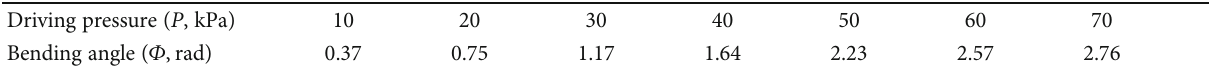
Figure 6: Pressurize expansion and bending of pneumatic soft-bodied bionic actuator. (a) Middle part actuating unit. (b) Left side actuating unit. (c) Right side actuating unit. Table 2: Numerical simulation algorithm calculation results.